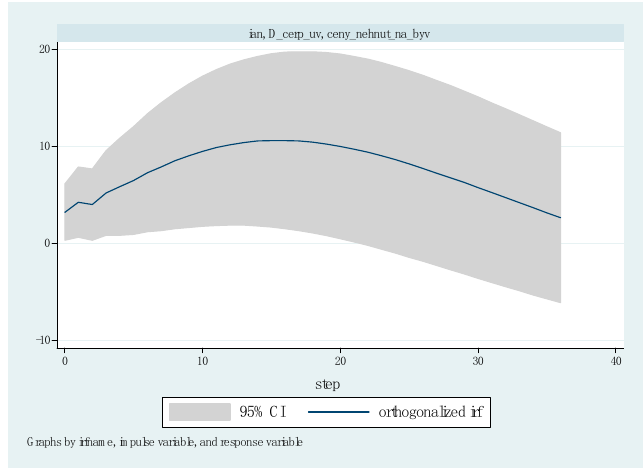
Figure 11. Impulse in the form of growth of loans and a response in the form of growth of real estate prices.